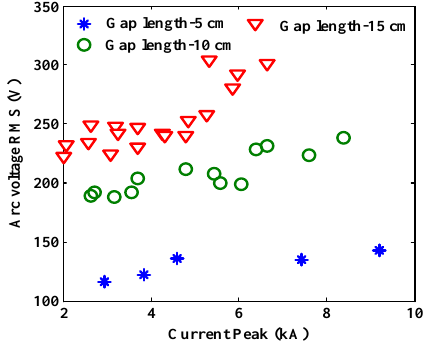
Figure 10. Change of the arc voltage with current peak under different gap lengths.